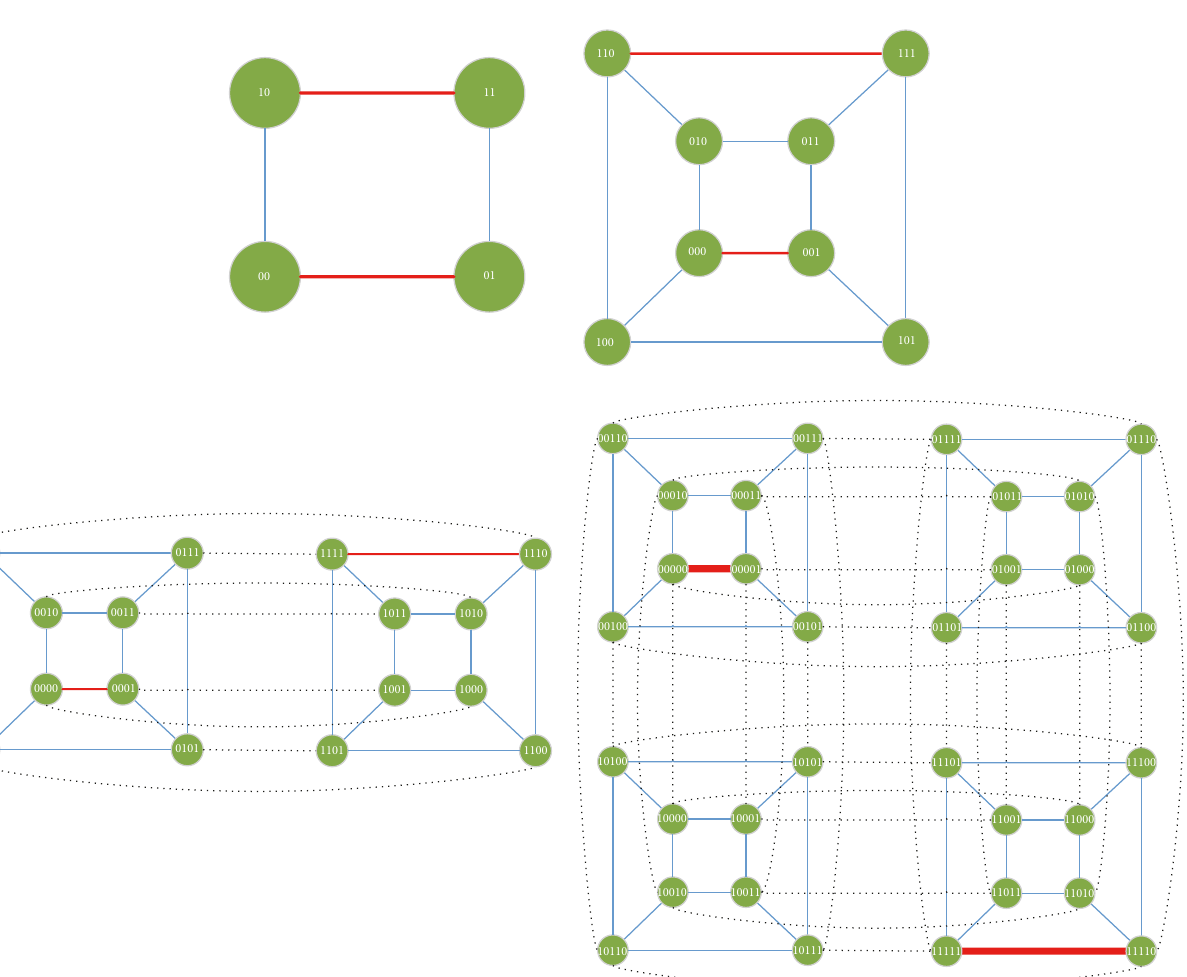
Figure 2: The proposed candidate in 𝐻 𝑛